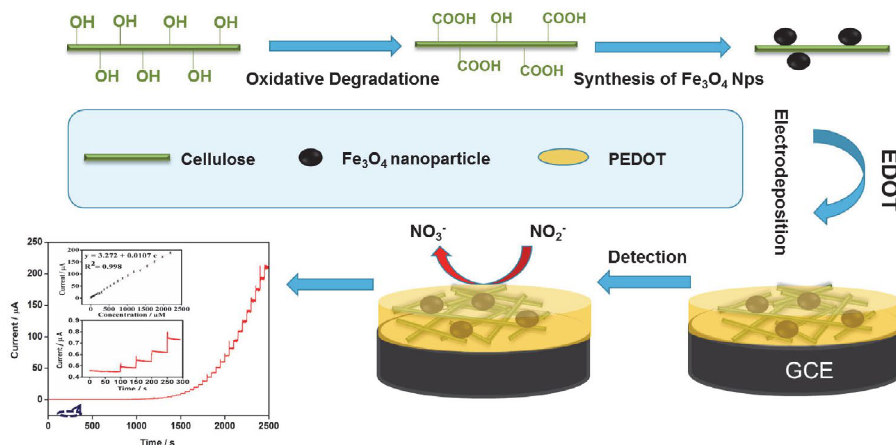
Fig 1. Schematic illustration of the preparation of the PEDOT/Fe 3 O 4 -CNCC/GCE and the proposed mechanism for the nitrite